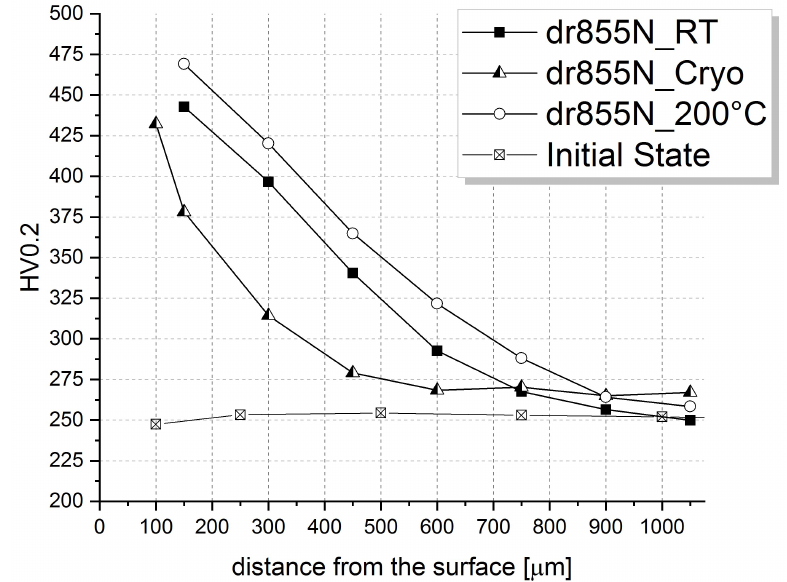
Figure 7. Hardness distribution in the near surface area after deep rolling in a temperature range from − 196 ◦ C (Cryo) to 200 ◦ C at a constant deep rolling force of